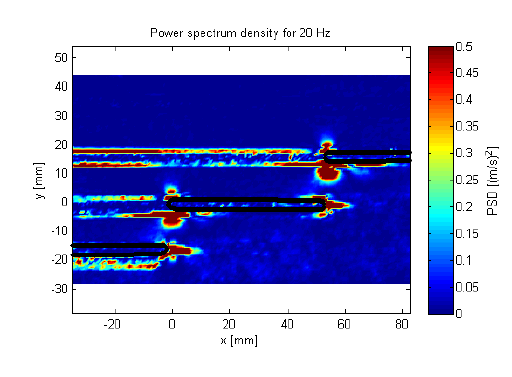
Fig. 7d. PSD scalar map for 20Hz, phase angle ϕ= -